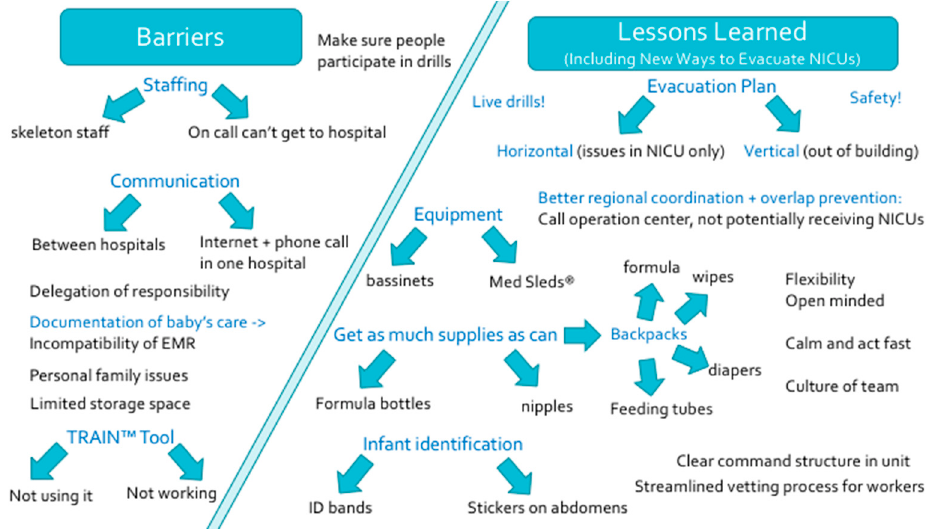
Figure 4. Barriers and lessons learned from wildfire disaster experience in California NICUs.